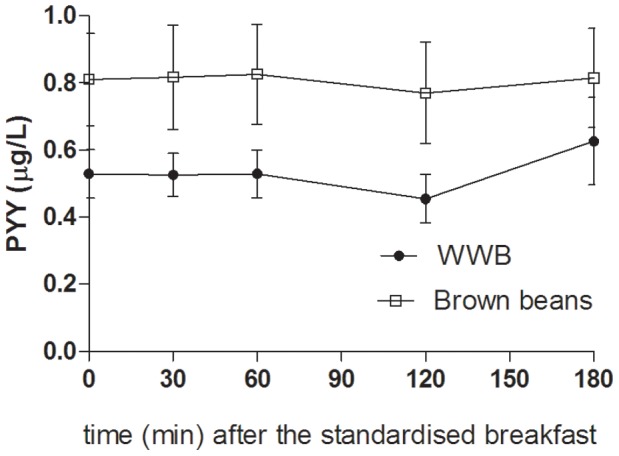
Concentrations of plasma PYY fasting and after a standardized breakfast, consumed 11 hours after evening meals composed of brown beans or WWB.A significant treatment effect (type of evening meal) was found over the test period (p<0.0001, PROC MIXED in SAS release 9.2; SAS Institute Inc, Cary, NC). n = 16 subjects.